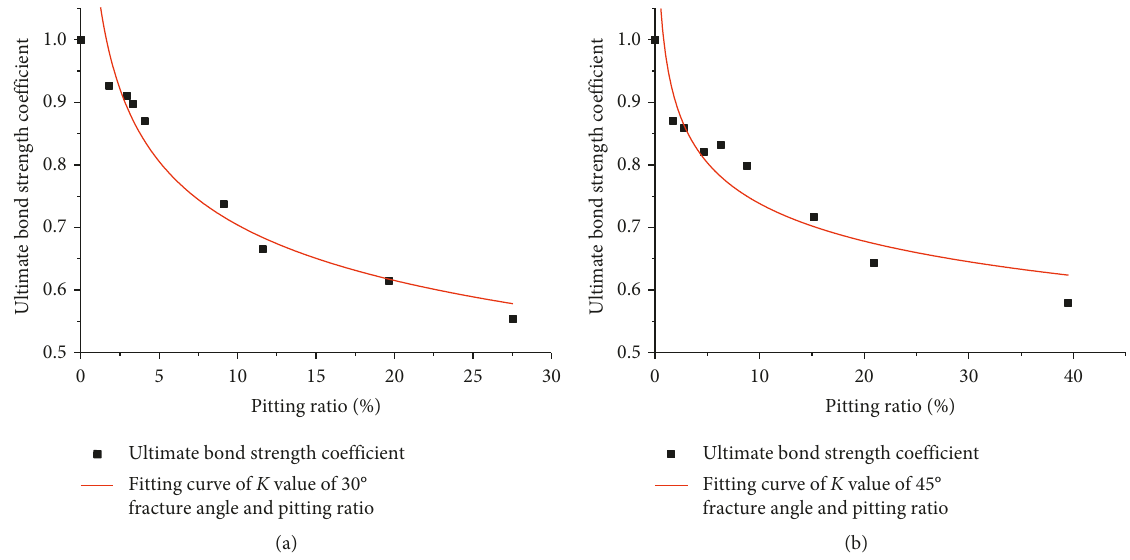
Figure 14: Fitting curve of pitting corrosion degree and ultimate bond strength coefficient K